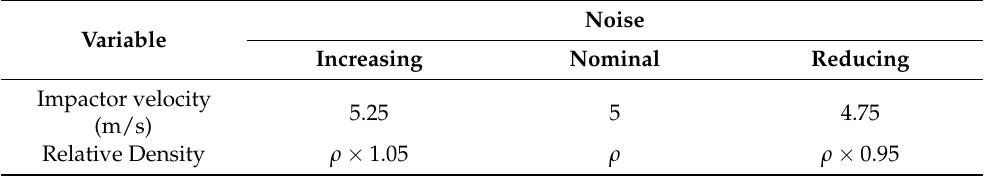
Table 3. Noise Applied in Finite Element Simulation.